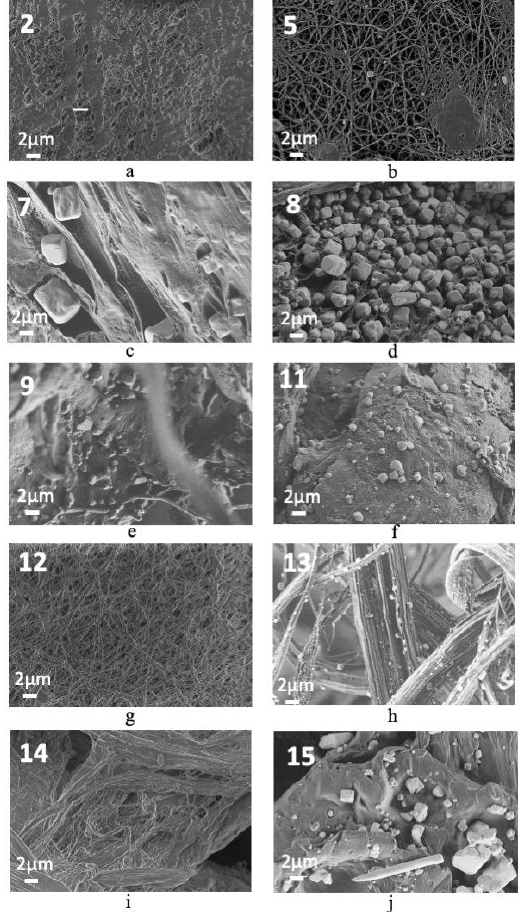
Figure 1. FE-SEM images of effective electrospun samples obtained from fractional factorial design samples: ( a ) sample 2, ( b ) sample 5, ( c ) sample 7, ( d ) sample 8, ( e ) samples 9, ( f ) sample 11, ( g ) sample 12, ( h ) samples 13, ( i ) sample 14, and ( j ) sample 15.